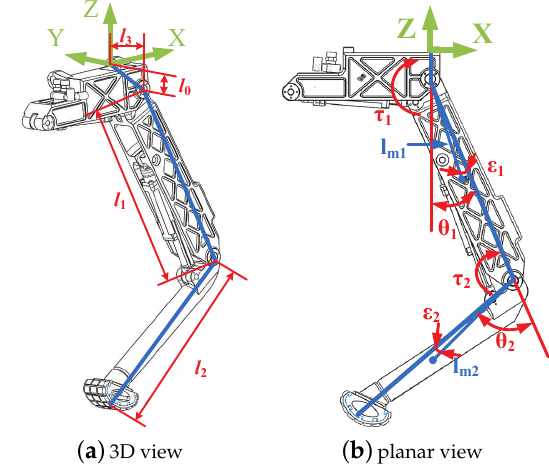
Figure 4. The model of the RF (Right Front)